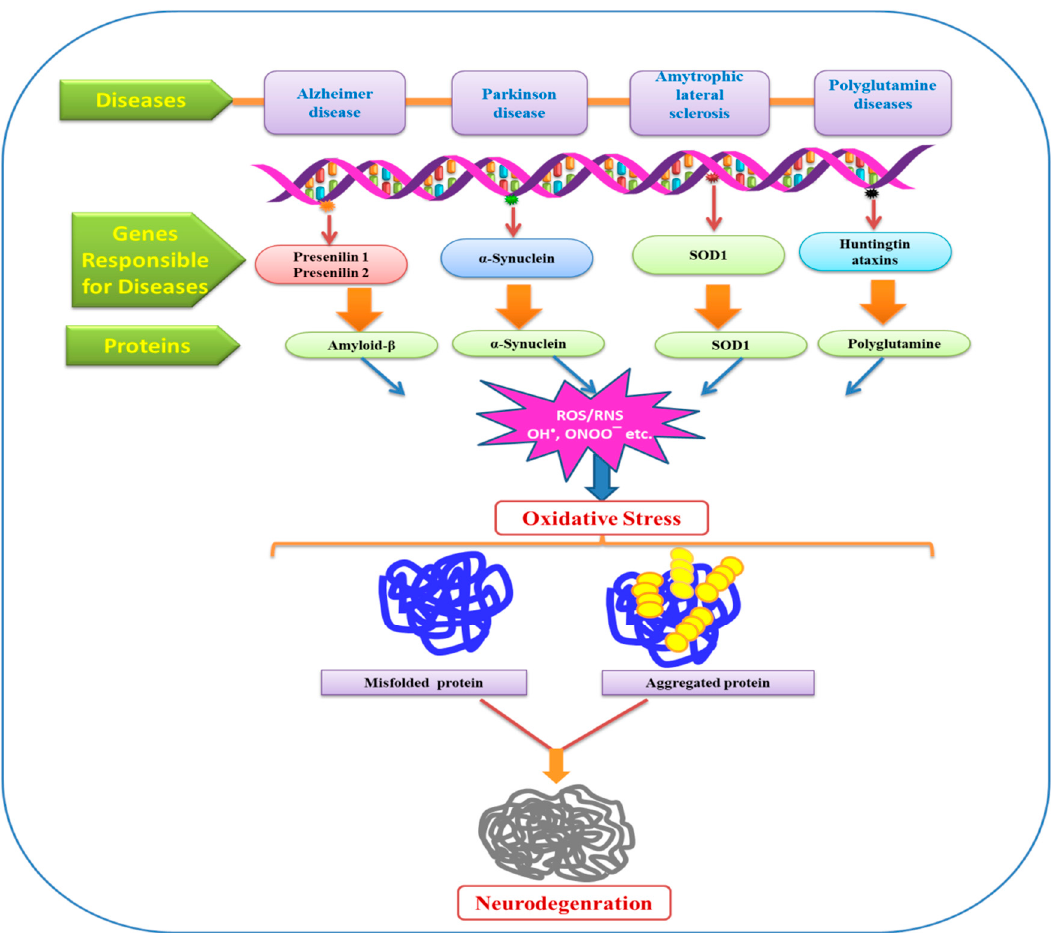
Figure 5. Role of ROS/RNS in oxidative stress thus results in protein damage and various neurodegenerative diseases. SOD—superoxide